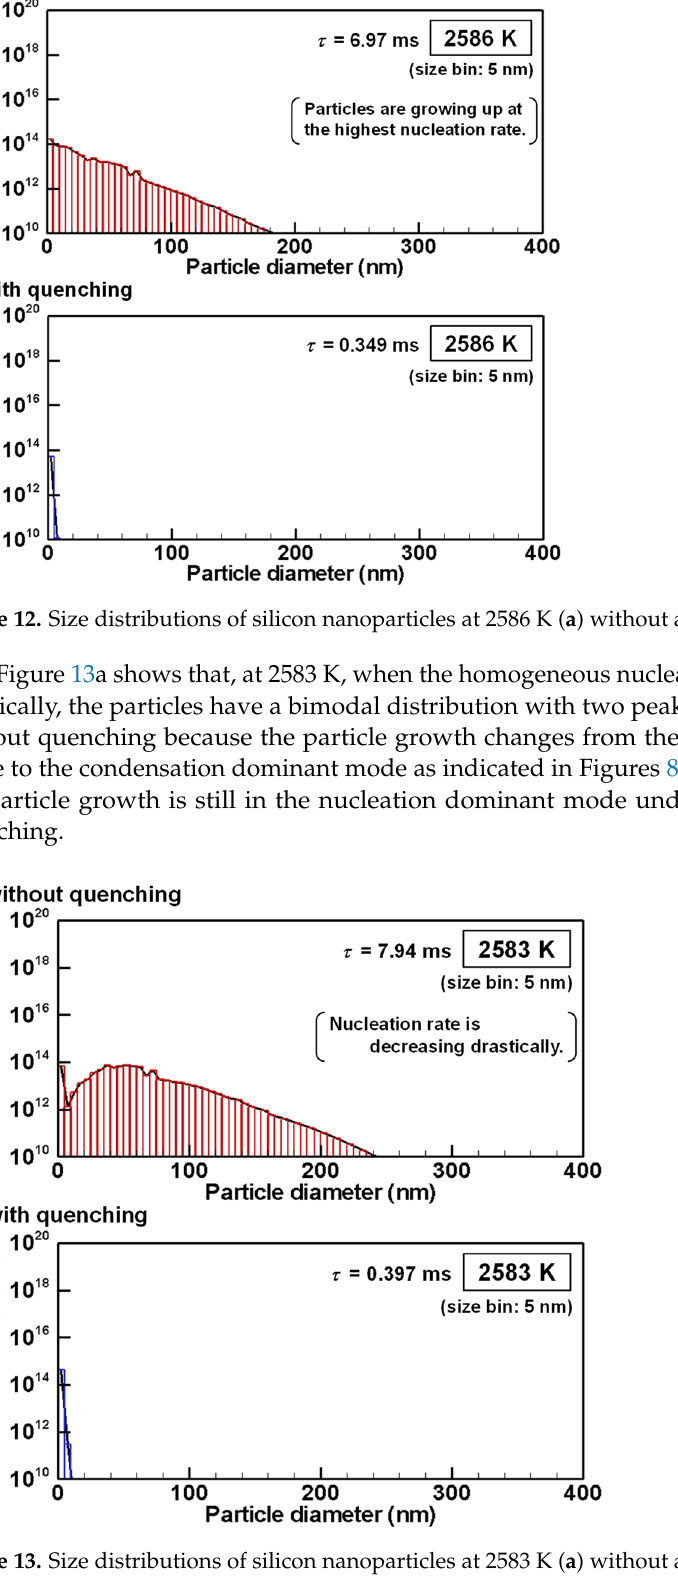
Figure 14. Size distributions of silicon nanoparticles at 2567 K ( a ) without and ( b ) with quenching.